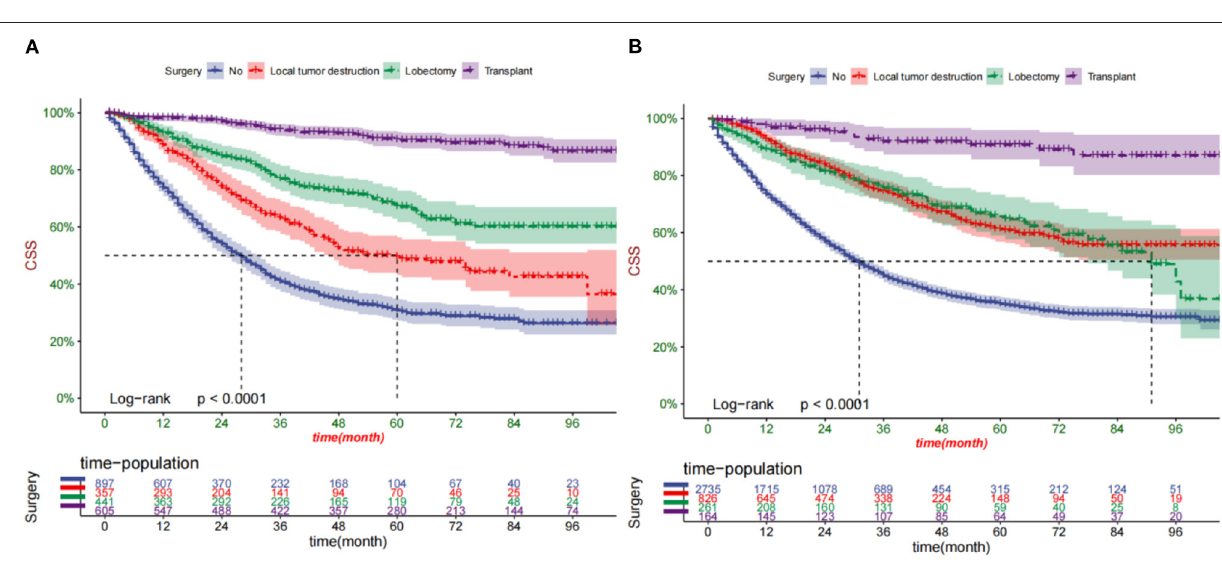
FIGURE 7 | Kaplan-Meier curves of patients with different surgical procedures in the low-risk group (A) and high-risk group (B)